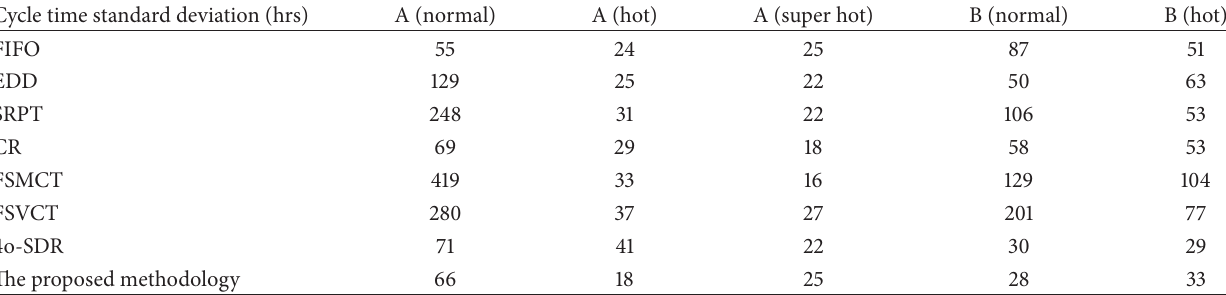
Table 9: The performances of various approaches in cycle time standard deviation.